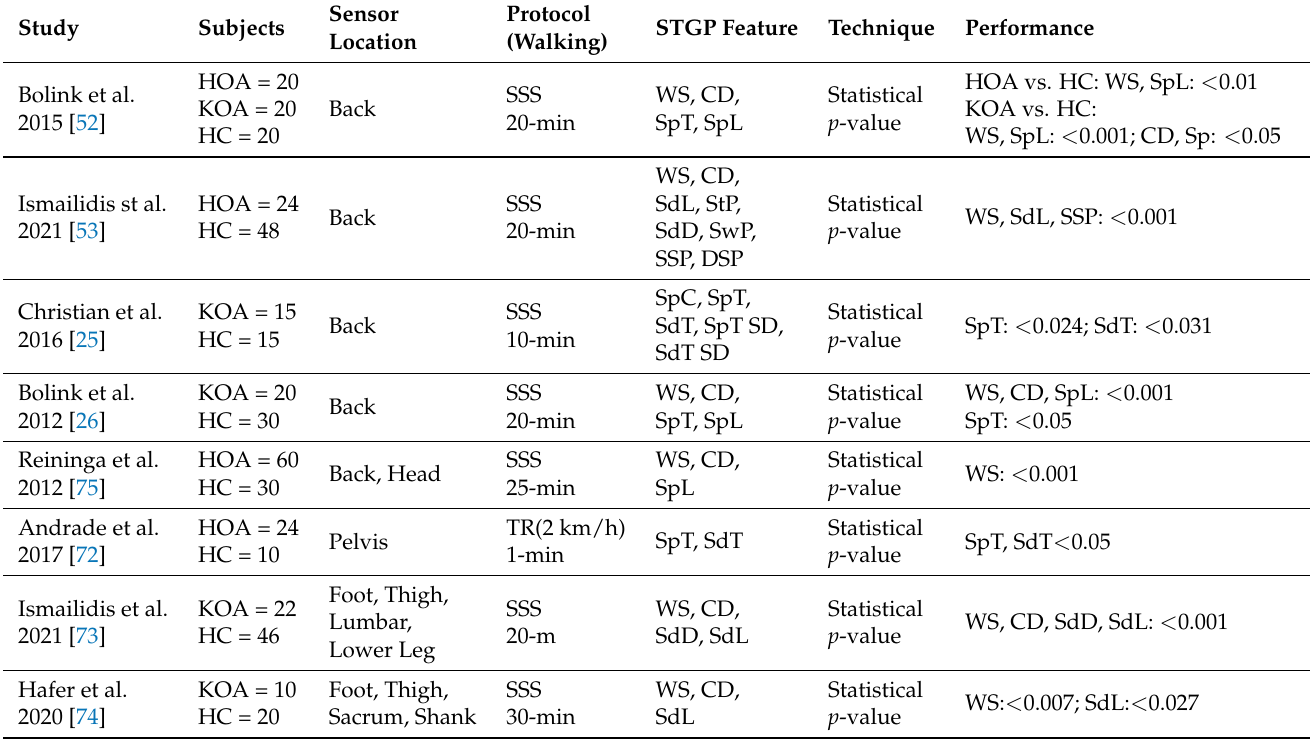
Table 1. Mean STGP features prior to HKOA studies have found statistically significant differences in HKOA patients vs. healthy controls. Technique